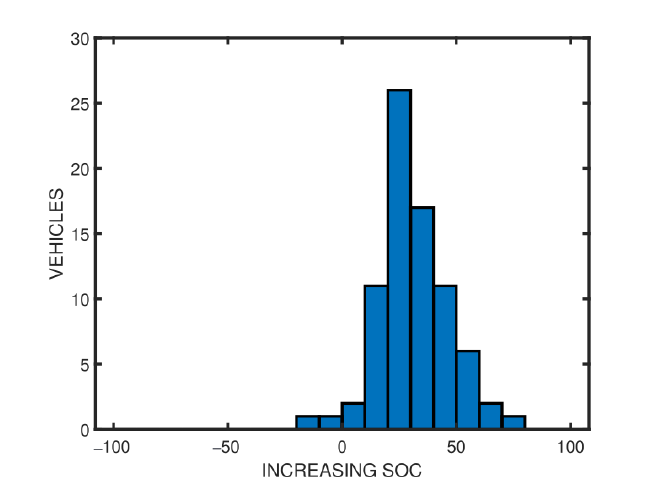
Figure 7. Distribution of the increase in SOC for EVs.